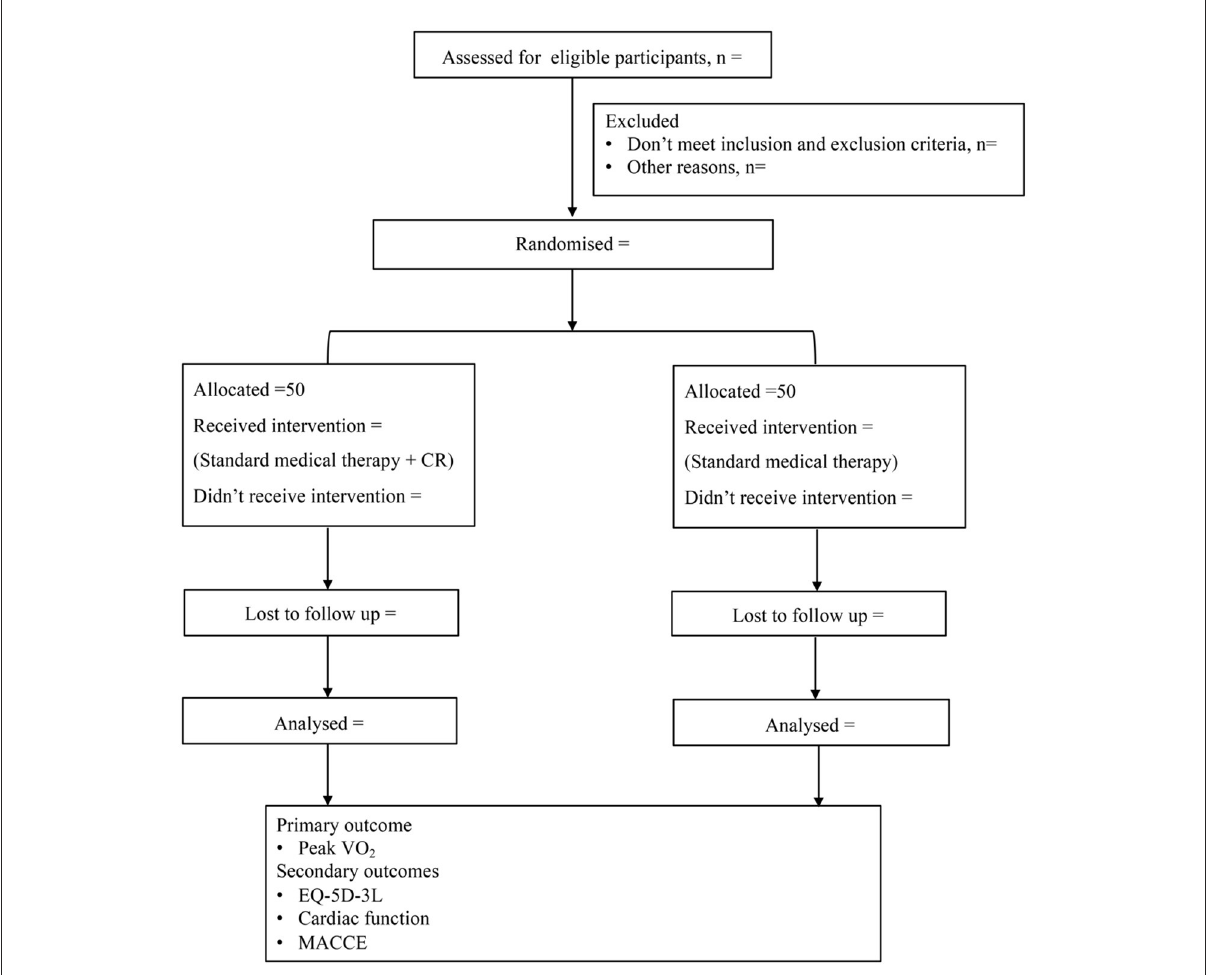
FIGURE1 Study design. CR, cardiac rehabilitation; VO 2 , oxygen uptake; EQ-5D-3L, EuroQol 5-Dimension-3 level; MACCE, major adverse cardiac cerebrovascular